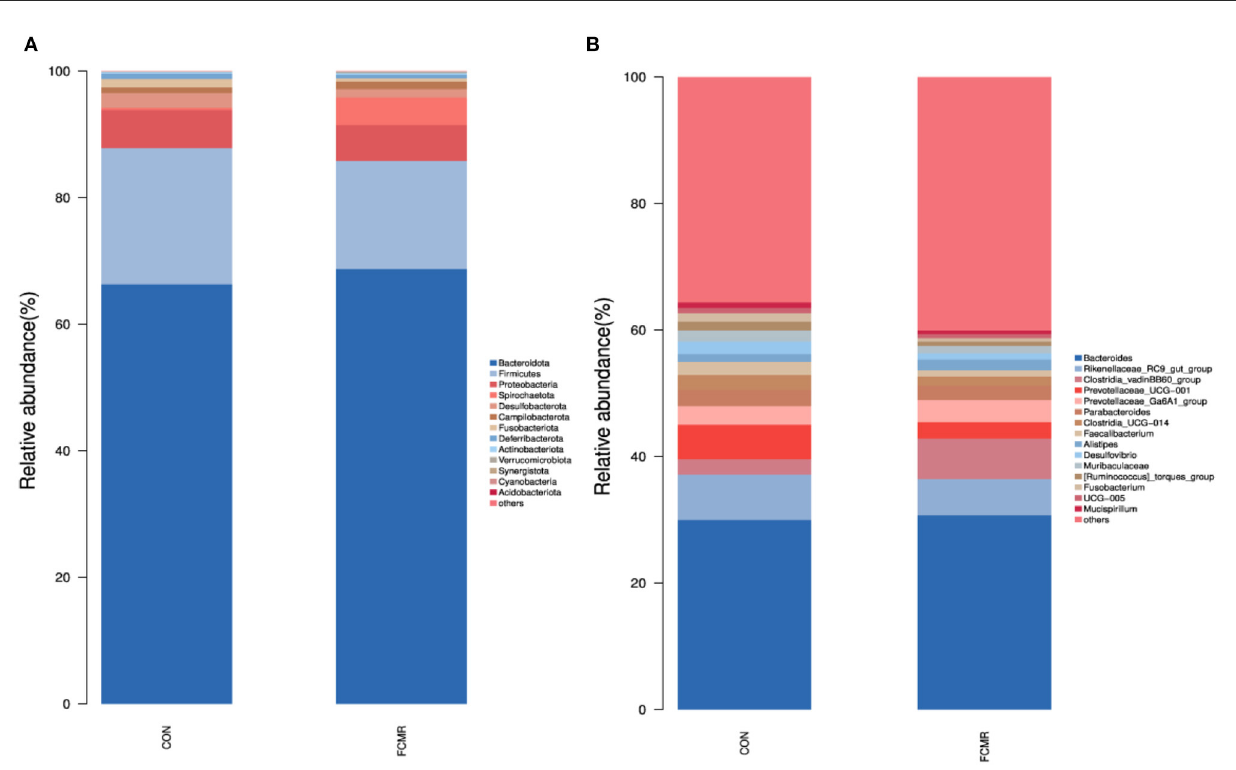
FIGURE4 The microbiota composition and identification of differential species in the cecum of birds. (A, B) The phylum and genus level compositions of the bacterial communities, respectively.